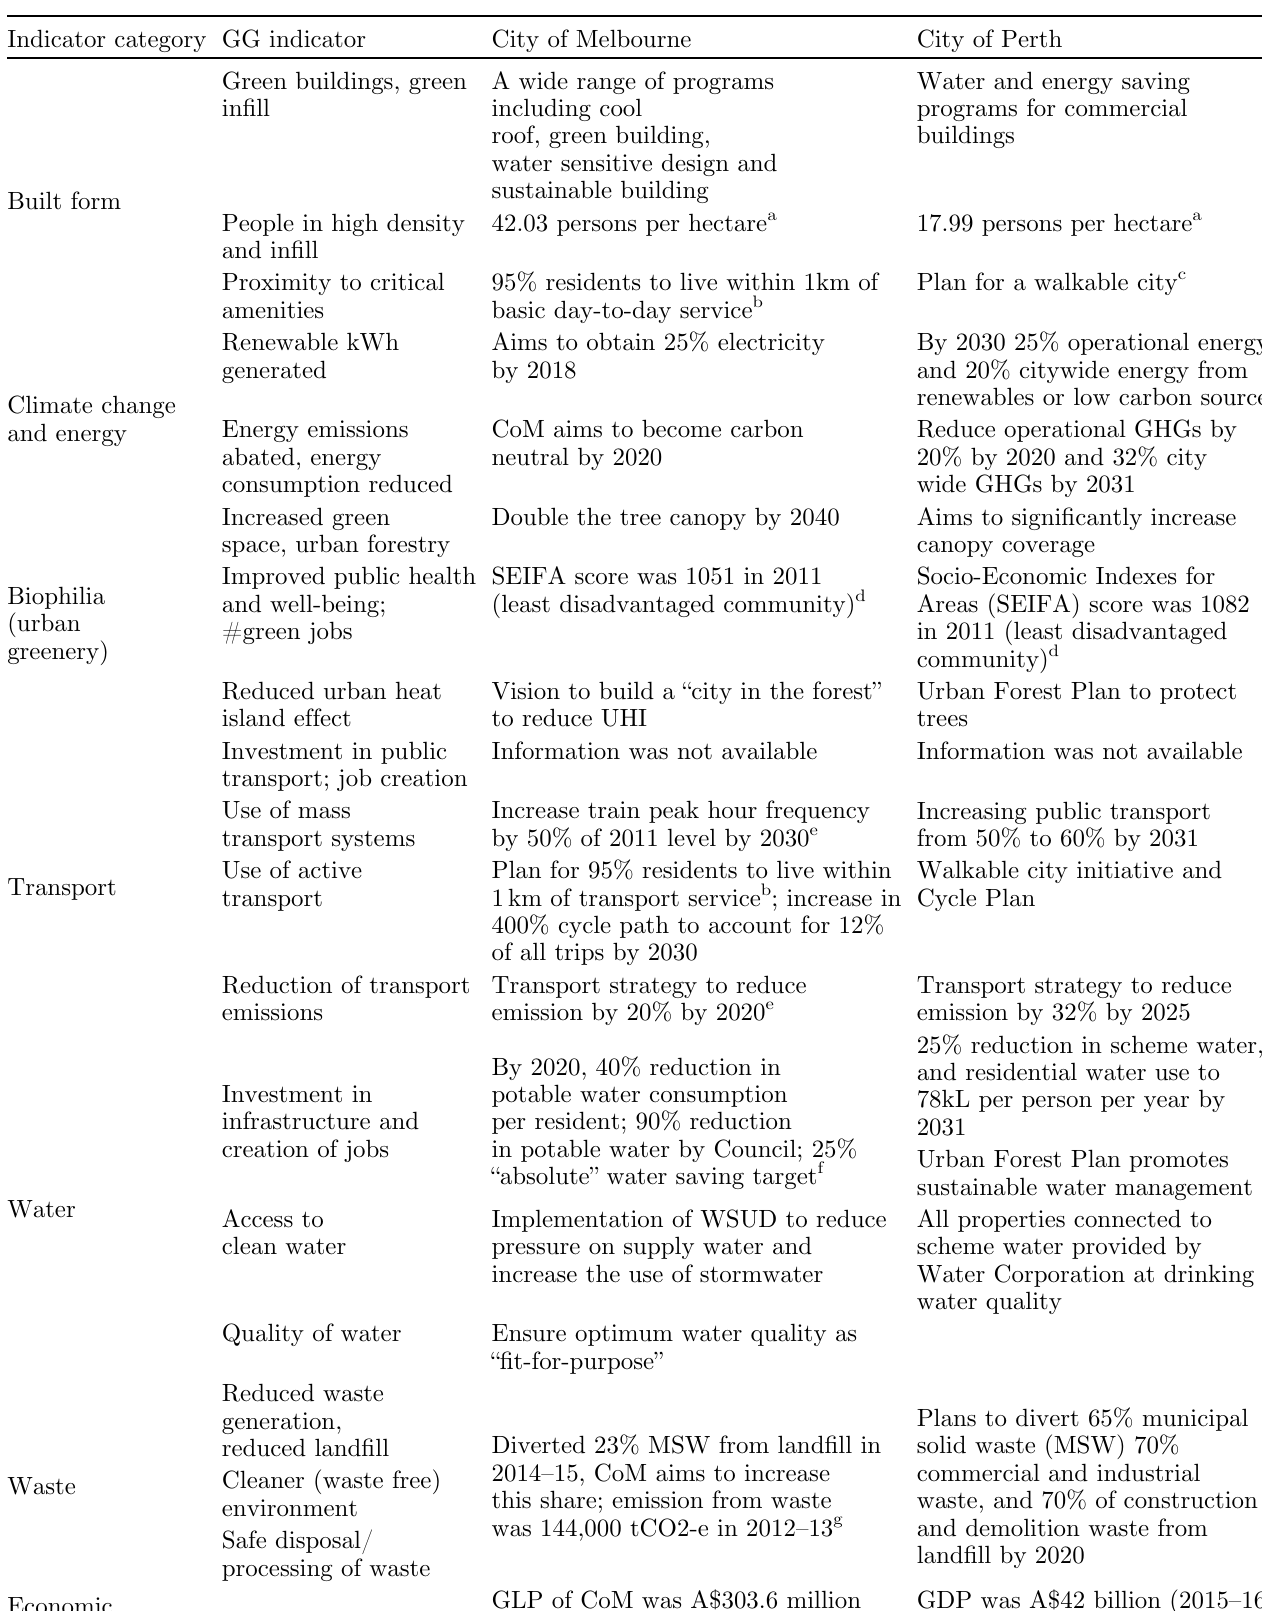
Table 2. Green Growth indicators with examples from the City of Perth and the City of Melbourne. Indicator category GG